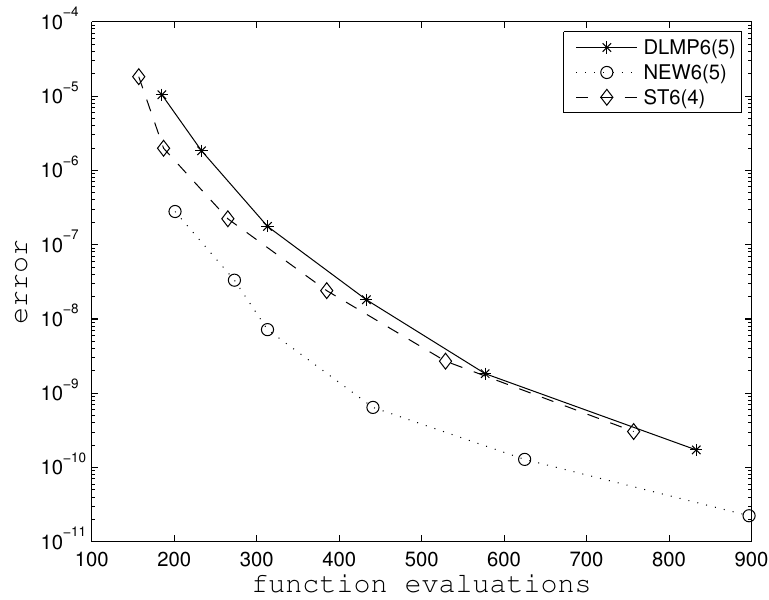
Figure 2. Efficiency plots for